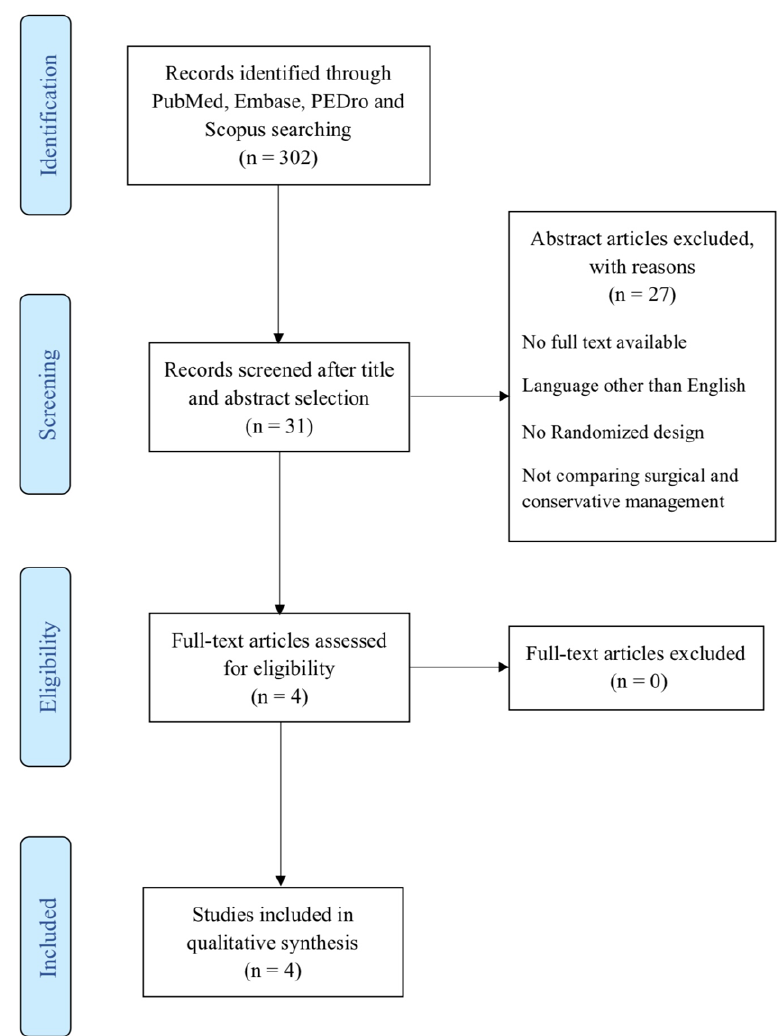
Figure 2. PRISMA Flowchart summarizing the selection